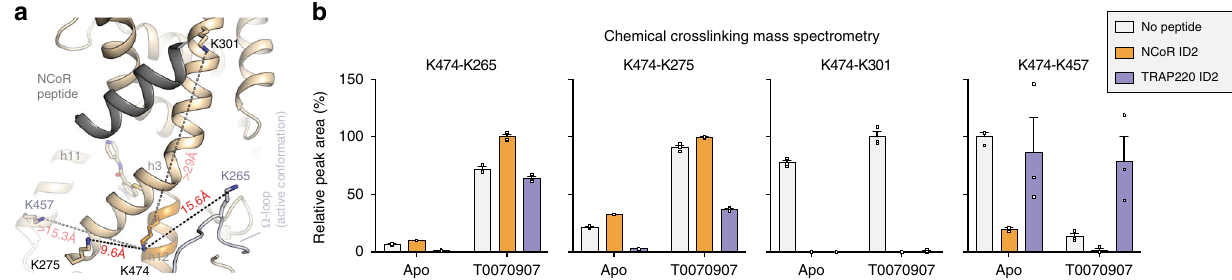
Fig. 8 XL-MS con fi rms the repressive helix 12 conformation within the orthosteric ligand-binding pocket. a Distances between K474 on helix 12 and several lysine residues structurally proximal to helix 12 (K265 and K275) or further away (K301 and K457) in the crystal structure of PPAR γ LBD bound to T0070907 and NCoR ID2 peptide (PDB 6ONI). b Relative peak area of four K474-crosslinked peptides normalized to a control uncrosslinked peptide and to the highest mean peak area within each condition (mean ± s.e.m.; n = 3). Source data are provided as a Source Data